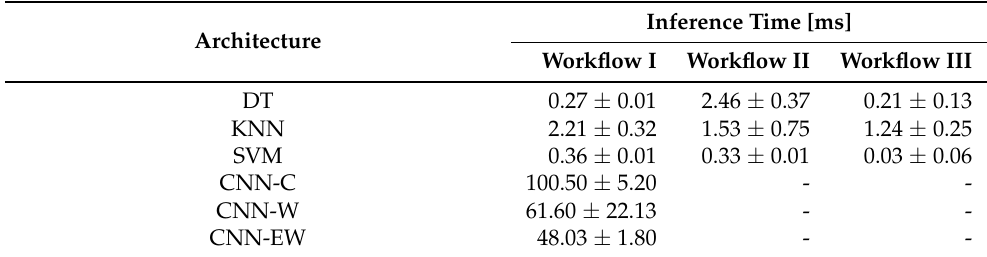
Table 5. Average and standard deviation time in milliseconds elapsed for single sample inference belong- ing to five-fold testing sets during prediction phase performed by classification methods and workflows illustrated. Measurements confirm the feasibility of inline testing and real-time quality